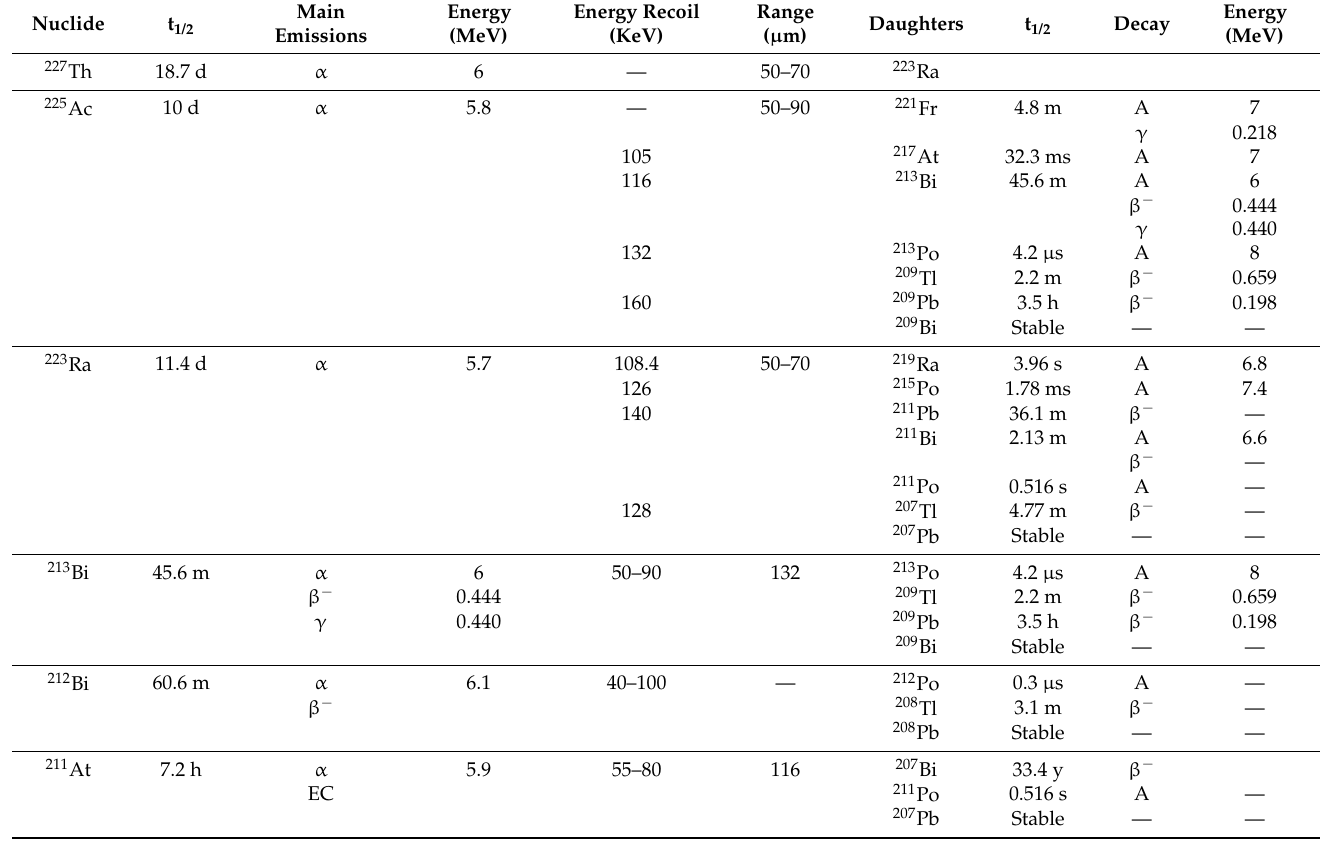
Table 1. Physical properties of main alpha emitters for